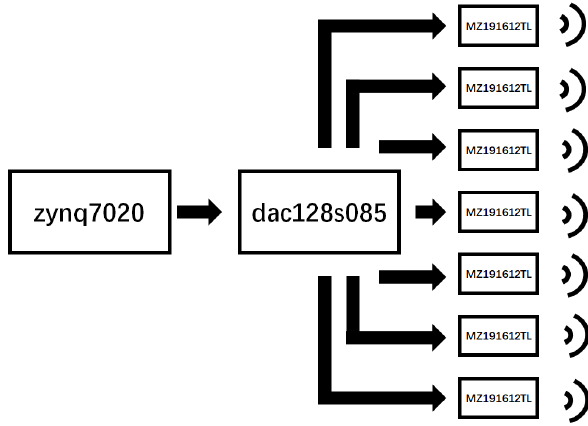
Figure 2. The topology of the hardware of the base station.